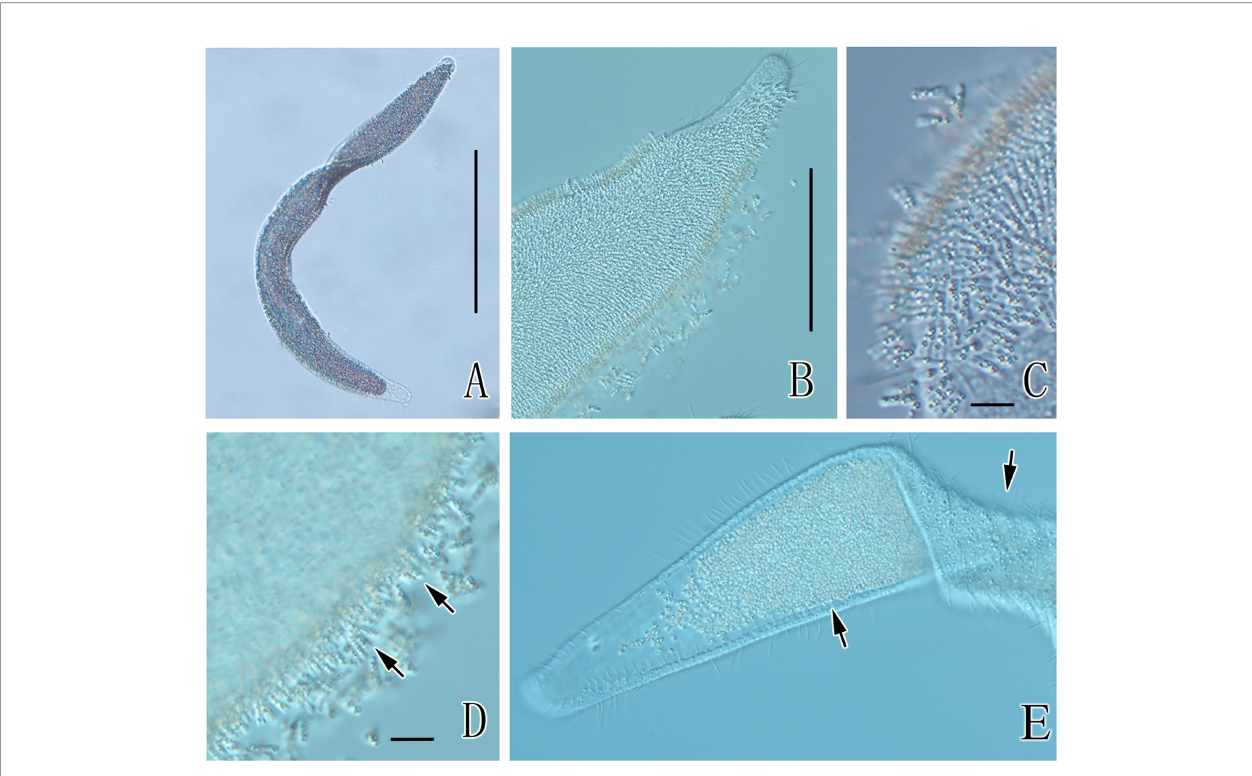
FIGURE 1 | Photomicrographs of Kentrophoros fl avus YE from life. (A) Typical individual showing fold-over shape while gliding on the substrate; (B) showing the dense rod-shaped bacteria on the cell surface; (C) showing refractile globules within the rod-shaped bacteria; (D) details of the body margin showing rod-shaped bacteria (arrows); and (E) folded individual shows symbiotic bacteria on only one side (arrows). Scale bars = 100 m m (A) ; 30 m m (B, E) ; 5 m m (C, D)